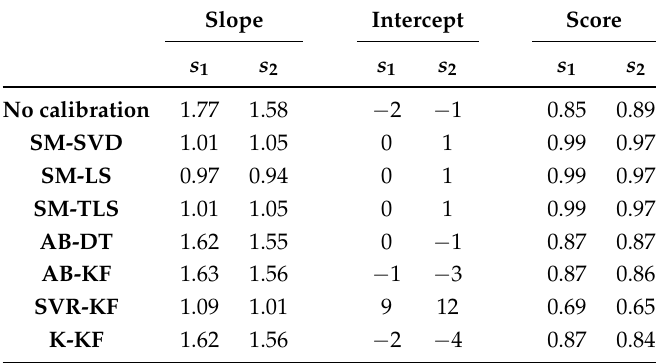
Table 5. Values of the parameters of the error model and the regression score, computed on the entire time interval of drift, for two particular sensors of the network s 1 = 2 and s 2 = 10. The observations that can be made with these values are identical to those of Table 2. Slope